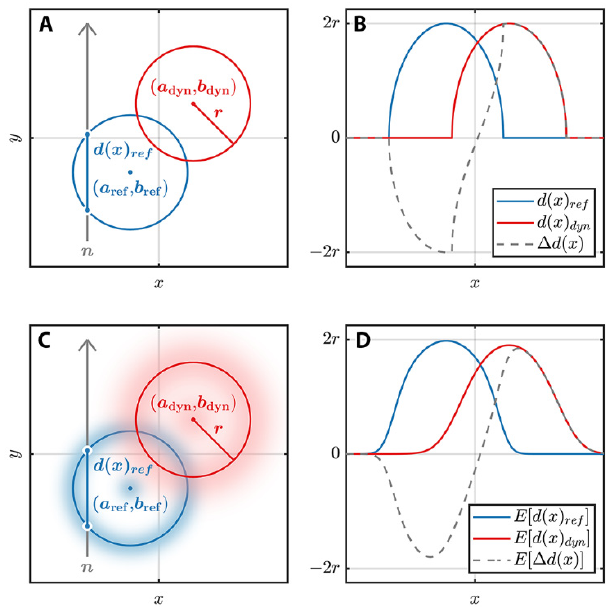
Figure 4. Illustration of path length variation through moving circles with discrete or probabilistic location. ( A ) Two circles at different discrete positions (reference and dynamic) in the xy plane with neutron path in the y direction denoted by n . ( B ) Path lengths and path length difference for paths in the y direction as a function of x . ( C ) Probability distributions for locations of two circles at different positions (reference and dynamic) in the xy plane. ( D ) Expected values for path lengths and path length difference for paths in the y direction as a function of x are smoothed out in comparison to the discrete path lengths in ( B ).